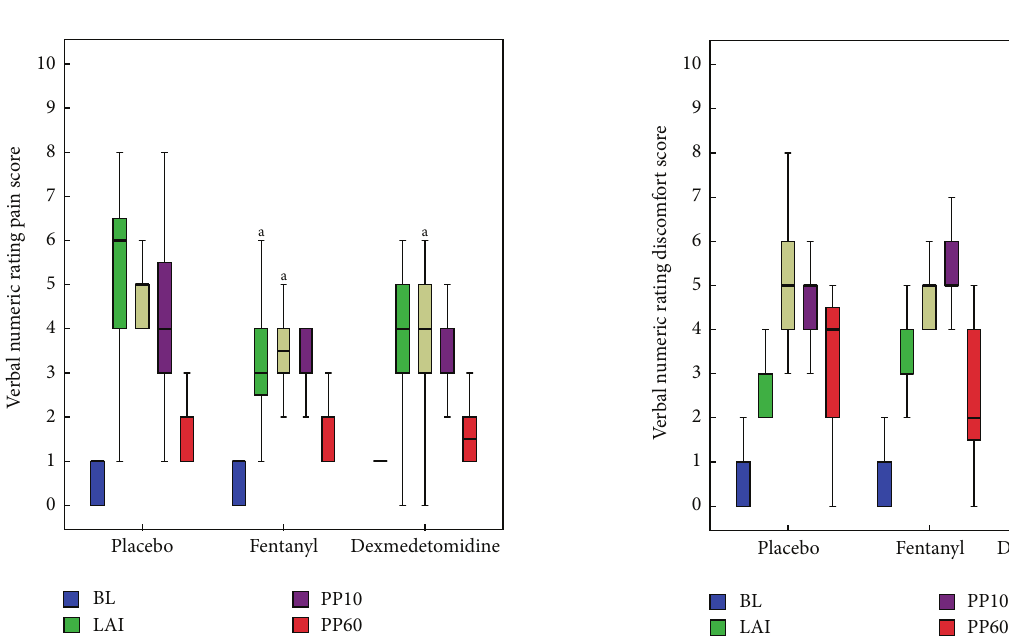
pain in the postprocedural period (LAI, PP3, and